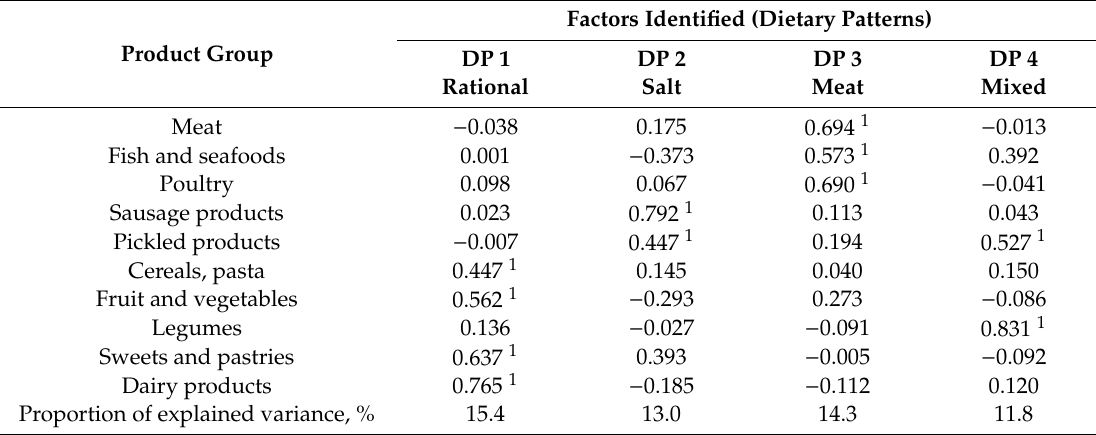
Table A11. Factor loadings of the principal dietary patterns identified (Voronezh region).